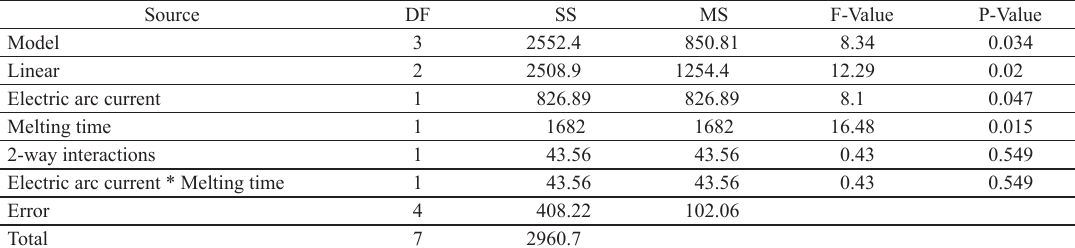
Table 4: ANOVA results of Vitreloy 105 experiment